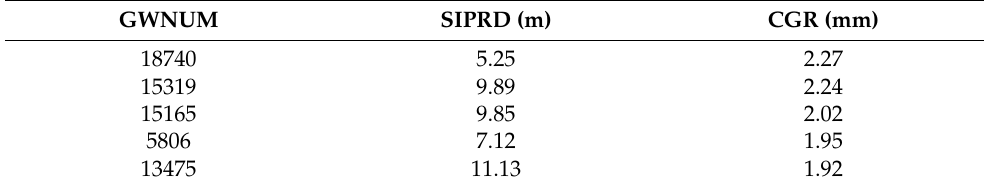
Table 3 ranks the highest short-term CGR along the pipeline. Table 3. Top 5 short-term corrosion growth rates.